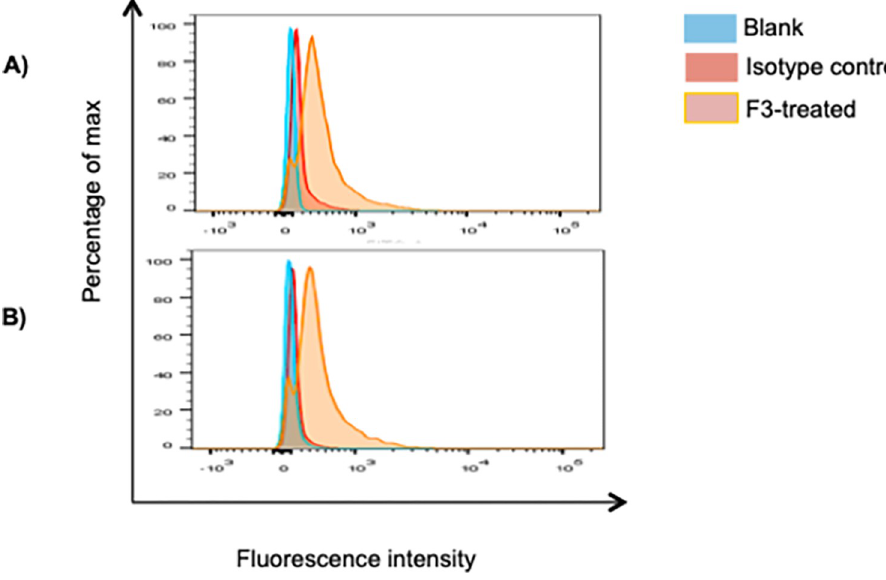
Fig 1. Expression of (A) MHC class I and (B) MHC class II on 4T1 cells treated with F3. The FACS results were analyzed using the FlowJo v.X.0.7 software (Tree Star Inc., Ashland, OR,